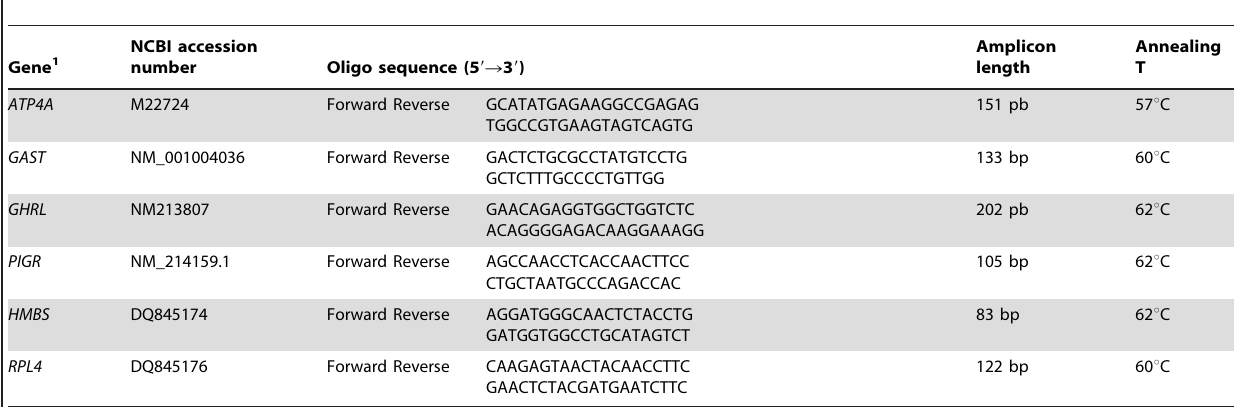
Table 1. Primers information and RT-qPCR conditions used in the trial.